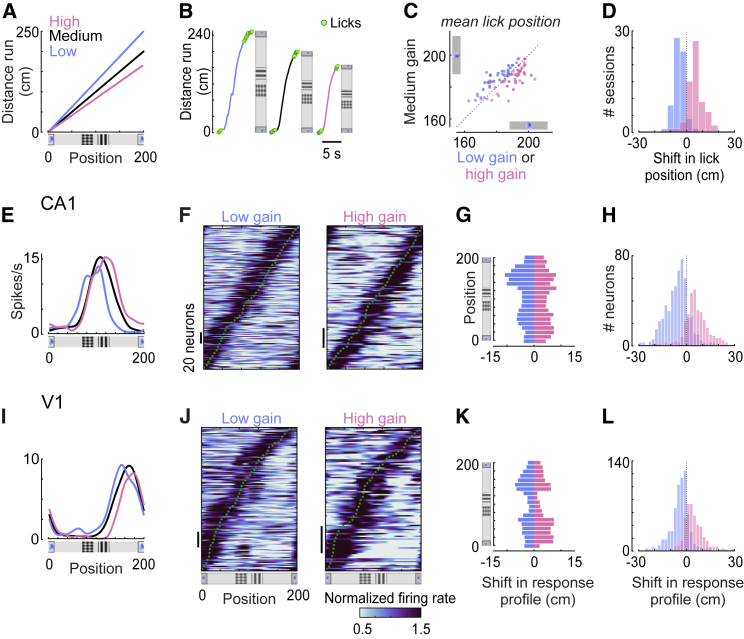
V1 and CA1 Neurons Are Modulated by the Distance Traveled in the Environment(A) Physical distance traveled from landmark L1 on trials with low, medium, and high gain.(B) Examples of single-trial trajectories for trials with low (blue), medium (black), and high gain (pink), showing the position of licks (green dots).(C) Visual position of licks on trials with low (blue) or high (pink) gain compared to medium gain. Each point is the average for a session.(D) Distribution of the shift in mean lick position across sessions in trials with low and high gain.(E) Response of a CA1 neuron on trials with low, medium, and high gain.(F) Response of CA1 neurons that showed a significant spatial shift of their response (in any direction) on trials with low gain (left; 42.4% of 559 neurons; p < 0.05, permutation test) or high gain (right; 40.4% of 329 neurons; p < 0.05). Neurons are ordered according to the position of maximal firing on trials with medium gain (dotted curve).(G) Median spatial shifts at low (blue) or high (pink) gain across all CA1 neurons as a function of the position of their peak response. Spatial shifts were measured in relation to the response at medium gain.(H) Distribution of spatial shifts in CA1 responses at low (blue) or high (pink) gain.(I) Response profile of a V1 neuron on trials with low, medium, and high gain.(J) Same as (F) for neurons in V1 (low gain; 24.4% of 667 neurons; high gain; 21.1% of 446 neurons, p < 0.05, permutation test).(K–L) Same as (G)–(H) for neurons in V1.See also Figure S3.